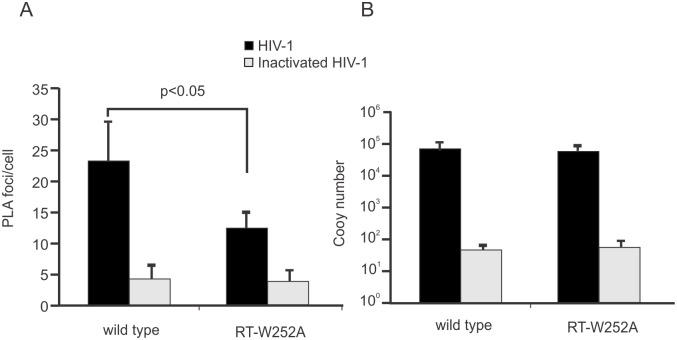
A W252A RT mutation reduces the association of RT with eEF1A in cells.Proximity ligation assays (PLA) were performed in TZM-bl cells infected with equivalent amounts of virus normalized to CA. Foci indicating association of RT with eEF1A were detected by fluorescence microscopy of cells infected with wild type or W252A RT mutant virus (bottom left panel), or with the same viruses that were heat-inactivated prior to infection. (A) Foci from PLA positive cells in 20 fields totaling at least 200 cells were quantified for each infection experiment. (B) Quantitative RT-PCR analysis of viral RNA in nevirapine-treated TZM-bl cells (to block reverse transcription of viral genomic RNA) infected with wild type or W252A RT HIV-1 or their heat-inactivated controls. The cytoplasmic RNA was extracted 2 h post-infection and measured by RT-PCR in triplicate. All values were normalized to cellular β-tubulin mRNA levels. All columns represent a mean value and standard deviation from at least three independent experiments. A p value for the wild type and W252A RT mutant HIV-1 outcome is shown.